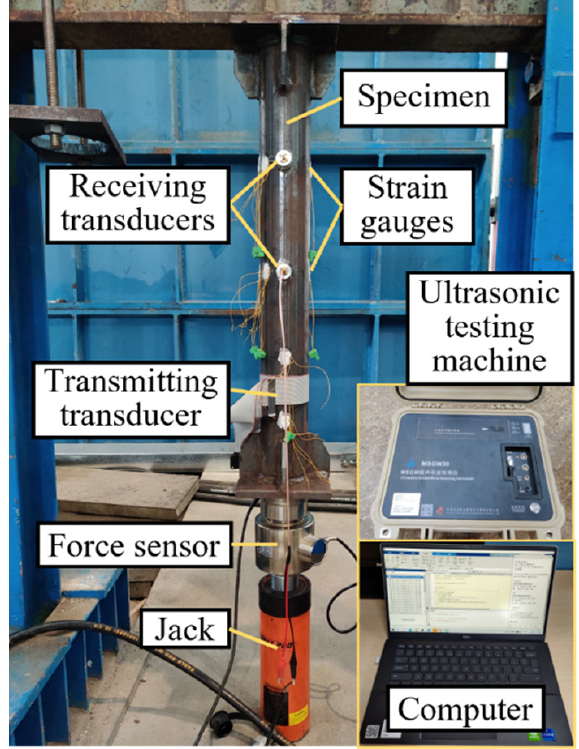
Figure 3. Photograph of equipment arrangements.